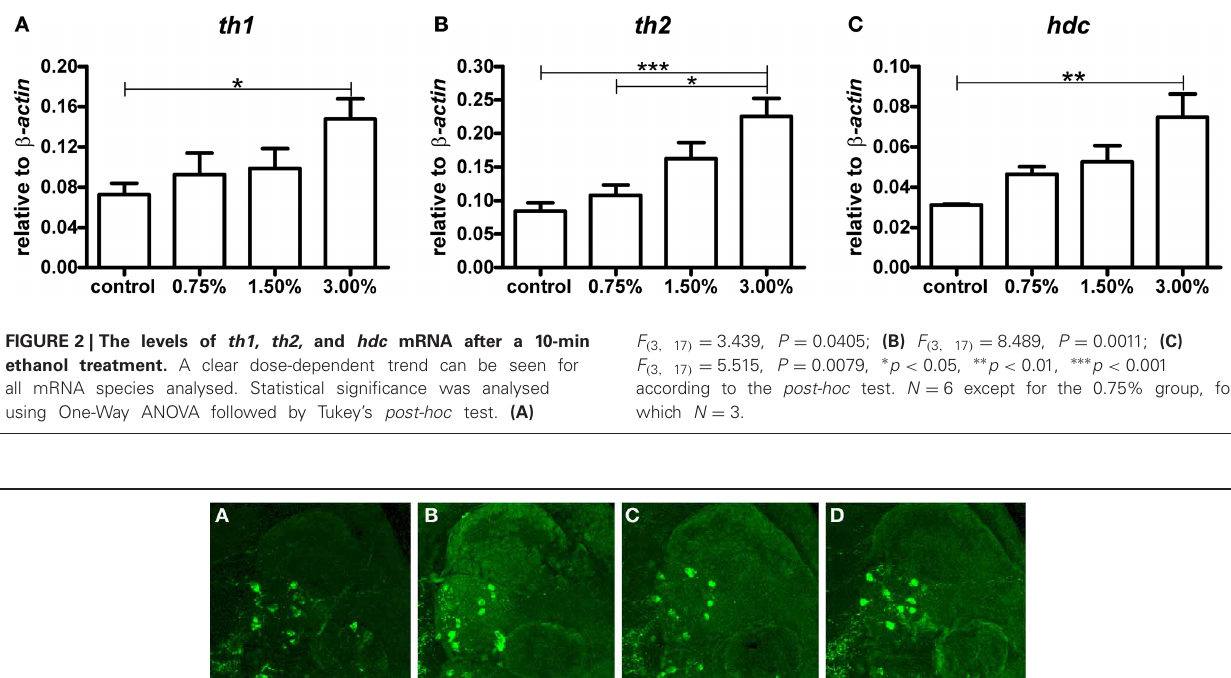
FIGURE 3 | Distributionof histamine-immunoreactive cells after a 10-min ethanol treatment. (A) Control, (B) 0.75% ethanol, (C) 1.50% ethanol, (D) 3.00% ethanol. No changes are seen between the groups, which are further confirmed by cell counting statistics in Figure 4 . N = 13–15 larvae per treatment group.